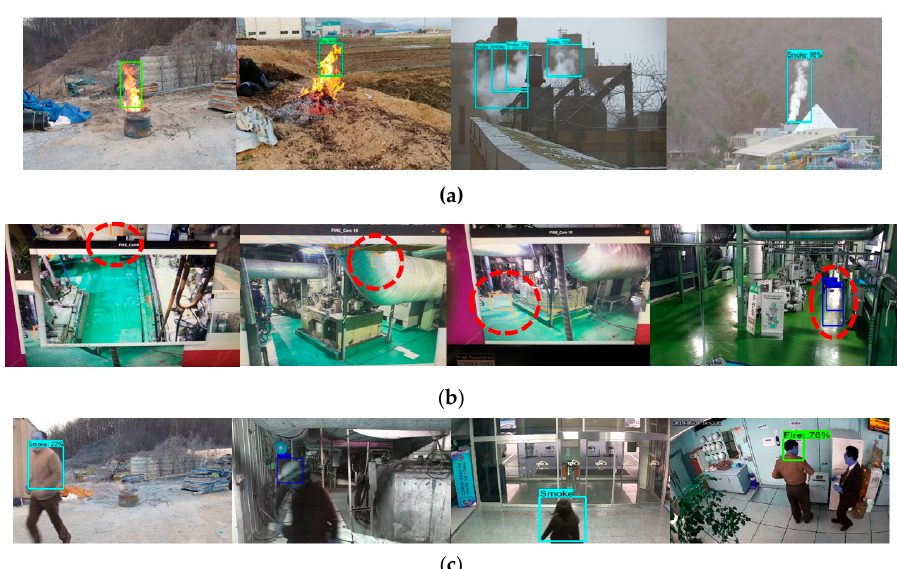
Figure 7. Example of the frame sequence of test video.